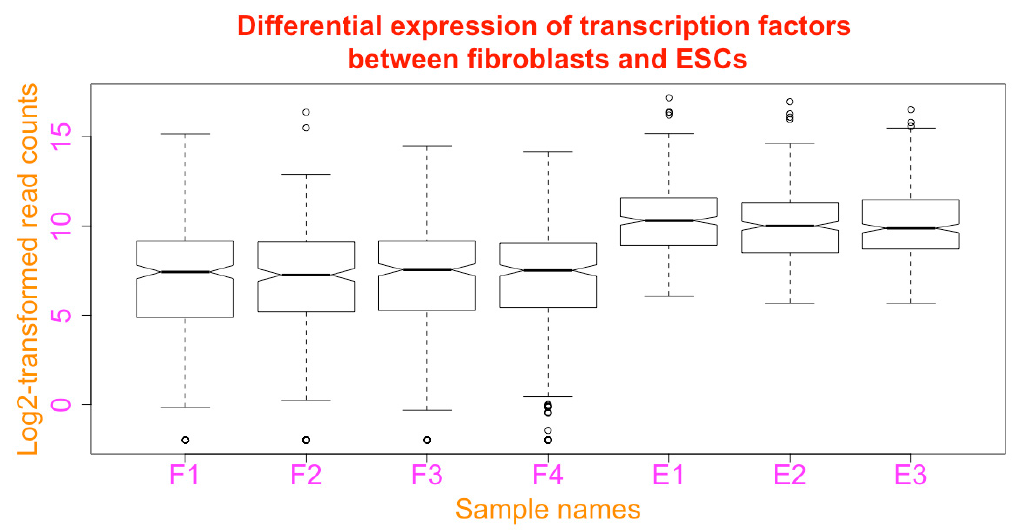
Figure 23. Change figure margins; add and modify figure title, axis titles and labels.